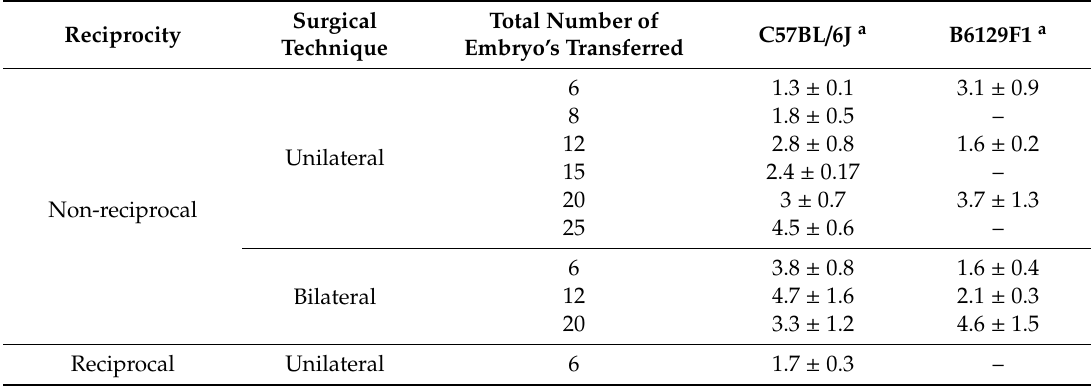
Table 4. B6129F1 transfer groups and results.